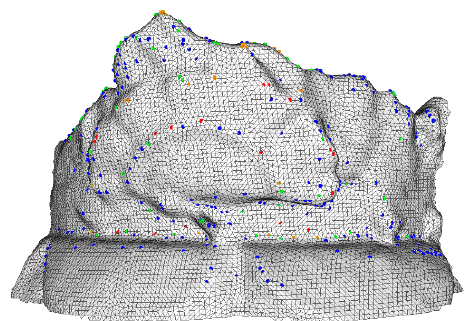
Figure 6. Significant points detected of four levels.